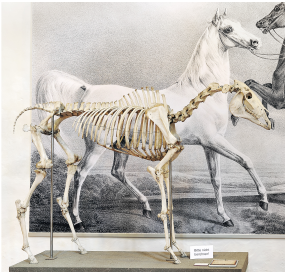
Figure 1. Skeleton of the Arabian stallion Bairactar Or. Ar. (1813–1838) in the Stud Museum O ff enhausen in Germany (copyright: Stephan Kube). A tooth from this skeleton was used for DNA